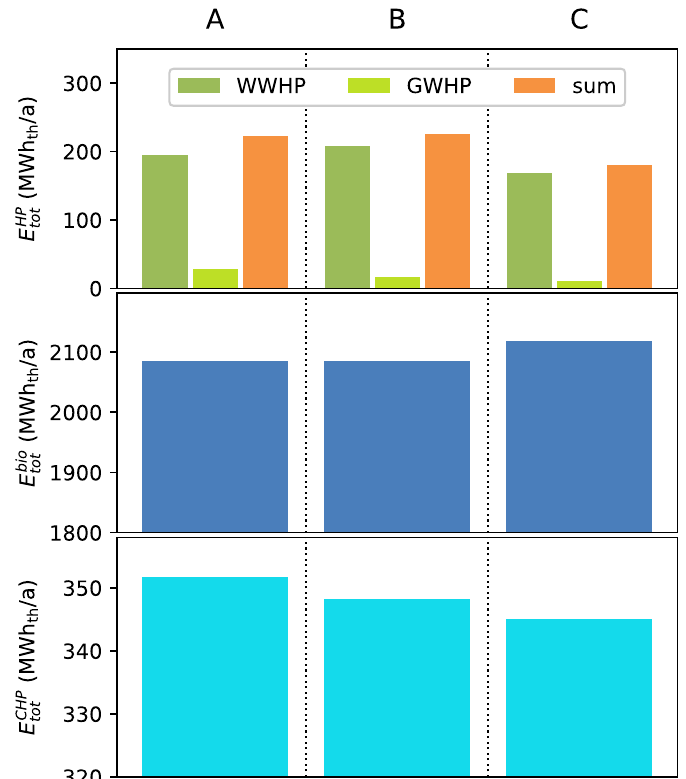
Figure 7. Comparison of the yearly thermal energy production of heat pumps, biomass boiler and CHP for the three considered system configurations (Configuration A, Configuration B and Configuration C).